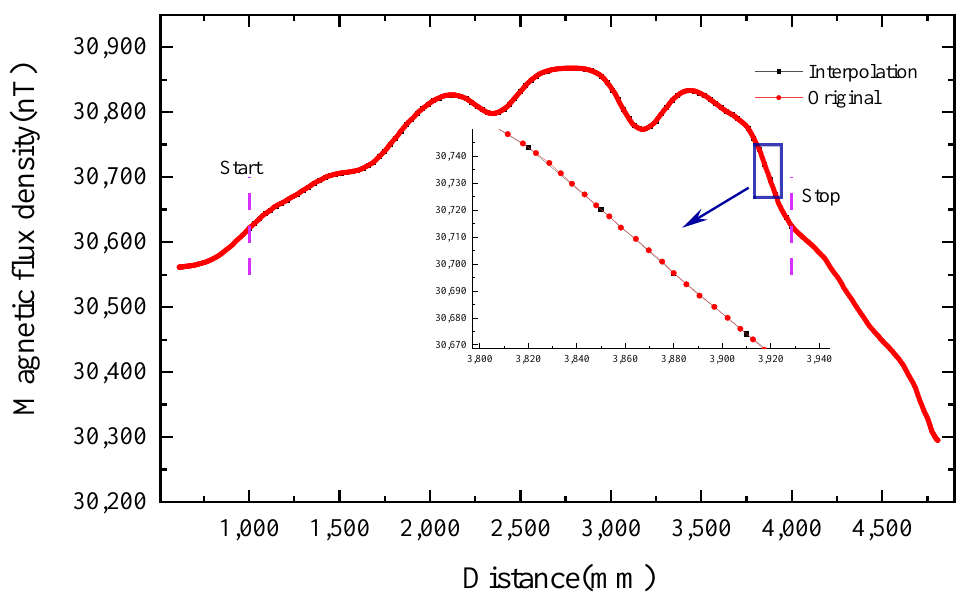
Figure 8. Interpolation calculation of the magnetic field position distribution.